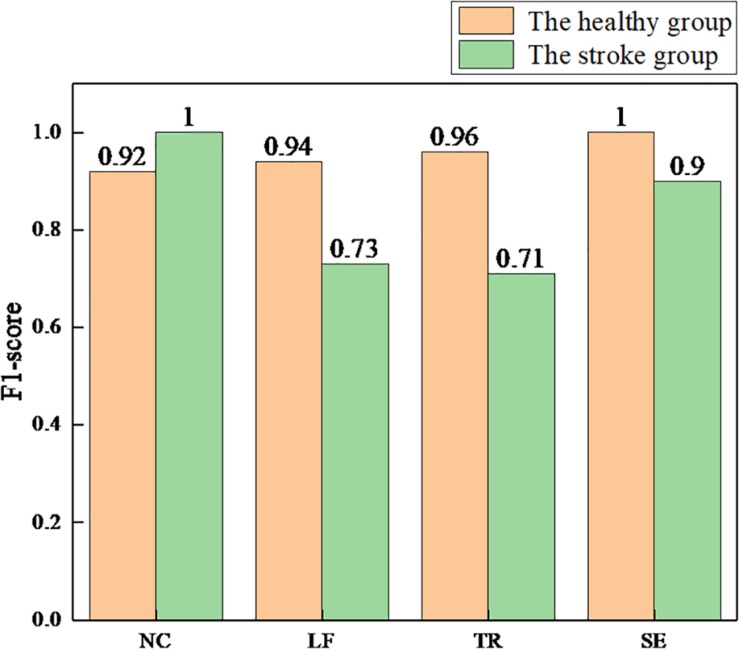
The F1-scores for each class of the health and stroke group models. NC, no compensation; LF, lean-forward; TR, trunk rotation; SE, shoulder elevation.